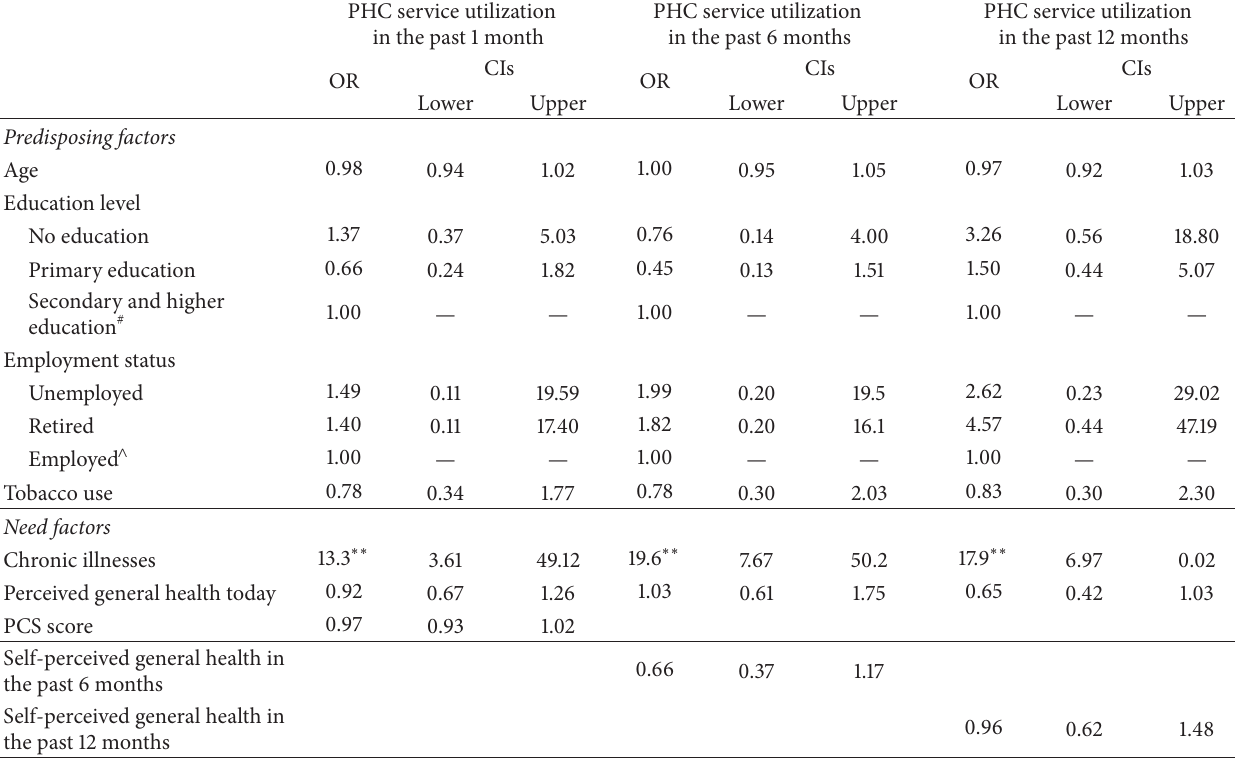
Table 3: Binary logistic regression analysis of predictors of primary health care service utilization of older adults in the past 1, 6, and 12